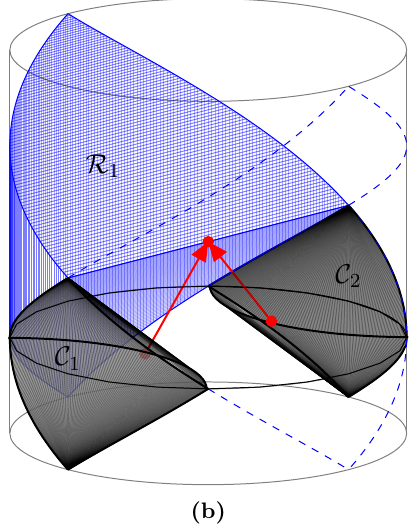
Figure 2. (a) A view of the boundary of AdS 2+1 . Left and right edges of the diagram are identified. Shown is an example choice of input regions ˆ C choice is maximal for the regions ˆ V regions, showing the entanglement wedges C cluttering the diagram. In the bulk there is a non-empty entanglement scattering region J E